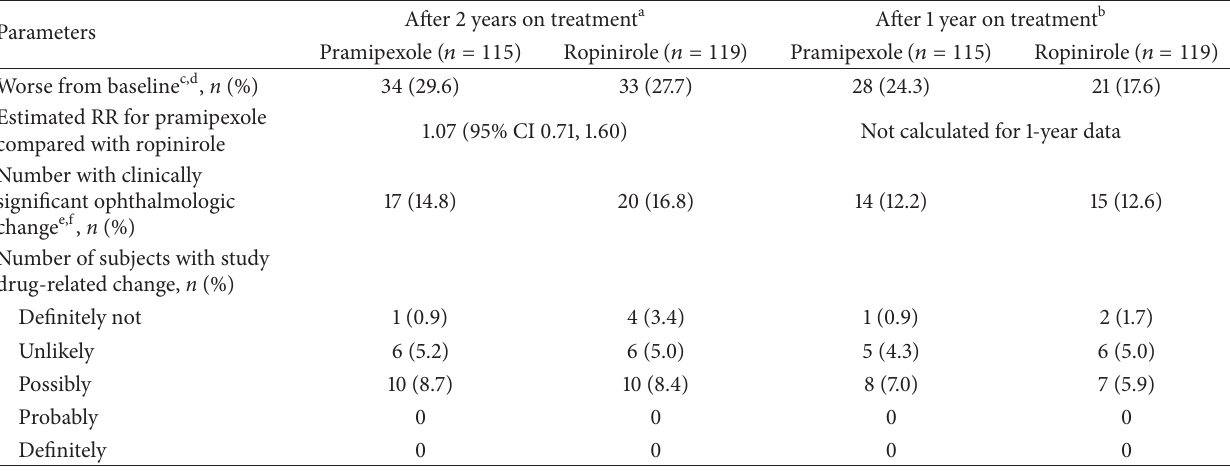
Table 4: Summary of Expert Panel’s COA (full analysis set, LOCF). The Expert Panel defined worsening as any of the following (thresholds determined from clinical experience and reading centers’ assessment of control subjects): Roth 28 error scores > 295 right eye, > 271 left; MD change of − 2 dB confirmed by a later test; field defect clusters of 3 locations at 𝑃 < 0.05 or 2 at 𝑃 < 0.01 ; ERG parameter change scores (log 10 differences from log 10 baseline values) < 2.56 times standard deviation of repeatability; fundus changes from “absent” to “obvious” for any finding; acuity loss ≥ 10 letters; pupil change from normal to abnormal; IOP > 22mmHg. Prespecified subgroup analyses of the COA